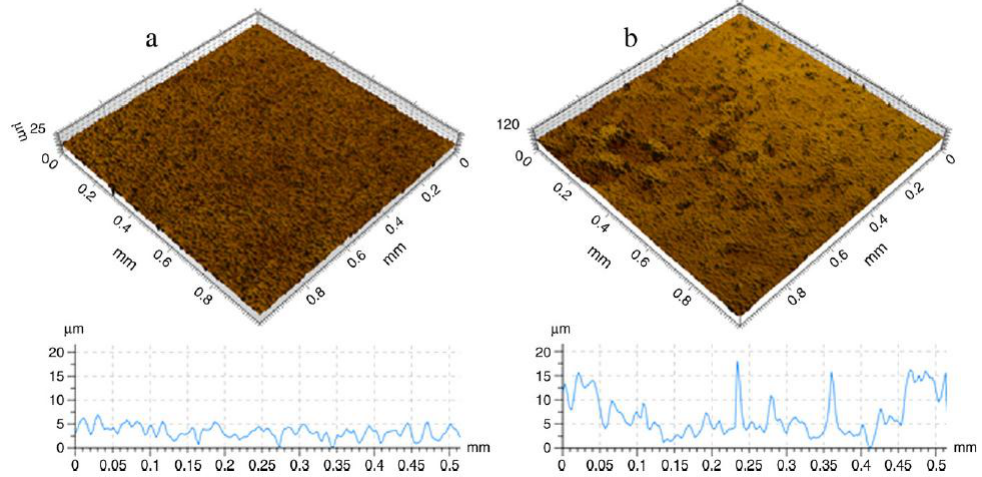
Figure 6. Topographic 3D view of machined CP-Ti ( a ) and MIM CP-Ti ( b ) surfaces, 1 × 1 mm [45].